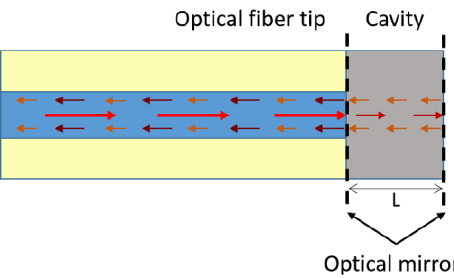
Figure 4. Schematic representation of an extrinsic Fabry-Perot interferometer on the tip of an optical fibre.